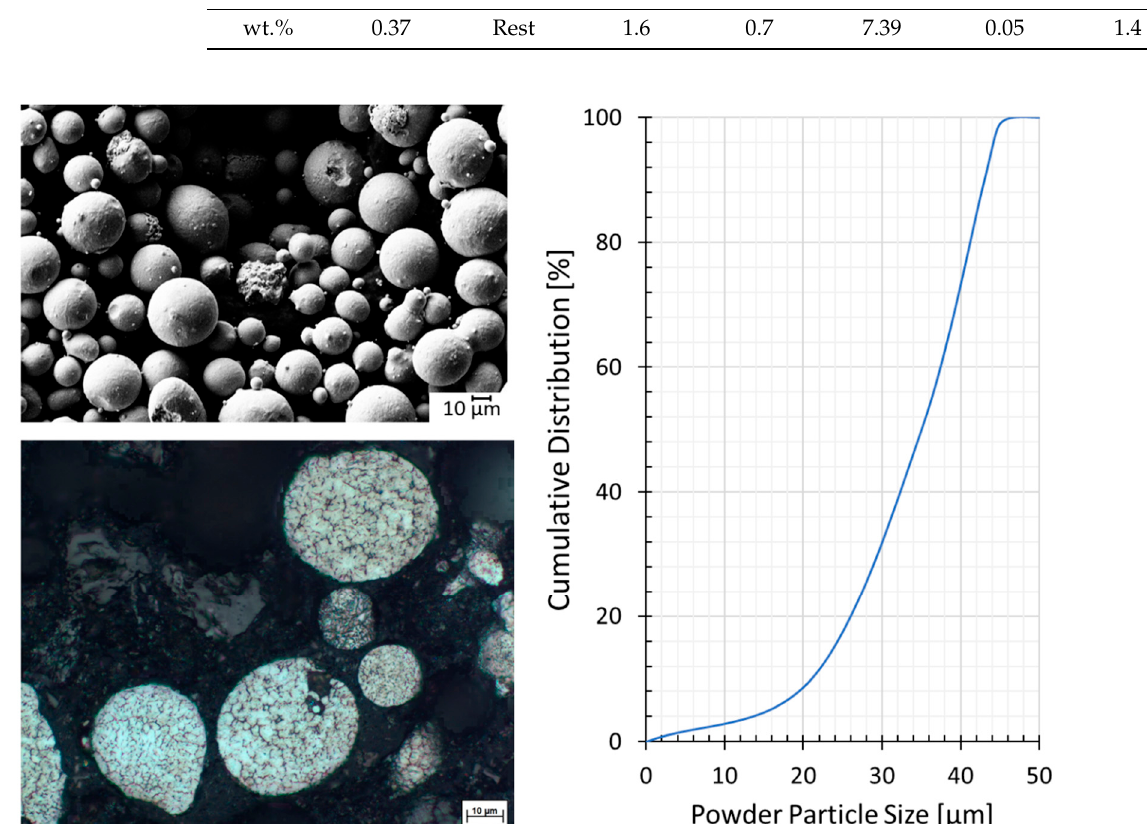
Figure 1. SEM images of 1.2343/H11 tool steel powder ( left ) and PSD ( right ).